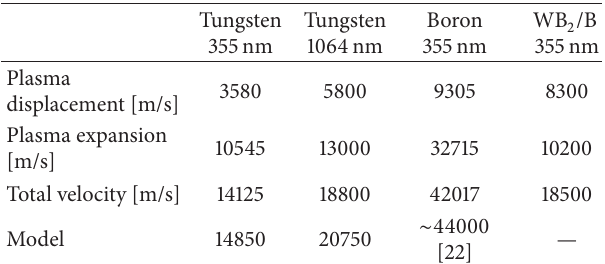
Table 1: Comparison of tungsten plasma velocity of W, B, and WB 2 /